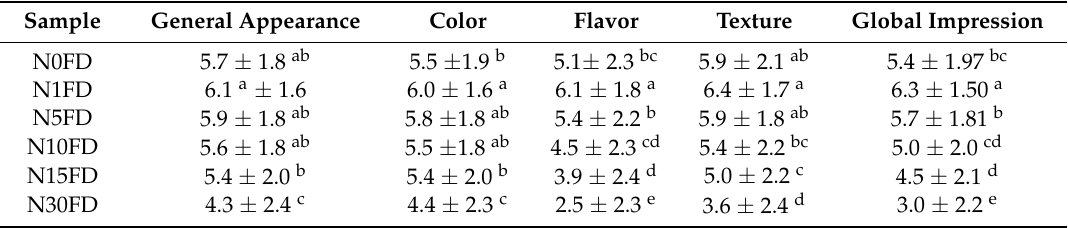
Table 3. Average * values for the sensory parameters evaluated in the acceptance test.